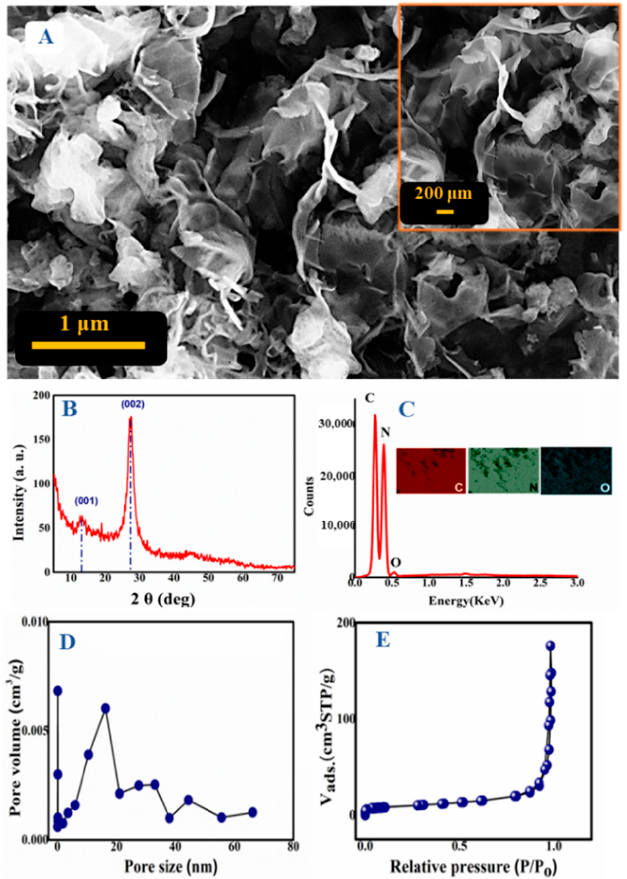
Figure 1. ( A ) Field emission scanning electron microscopy (FESEM) images with high and low mag- nification, ( B ) Energy Dispersive X-Ray (EDX) spectra and elemental mapping, ( C ) X-ray diffraction (XRD) spectra, ( D ) Brunauer-Emmett-Teller (BET) adsorption-desorption isotherm, and ( E ) pore size distribution of the prepared graphitic carbon nitride (g-CN).